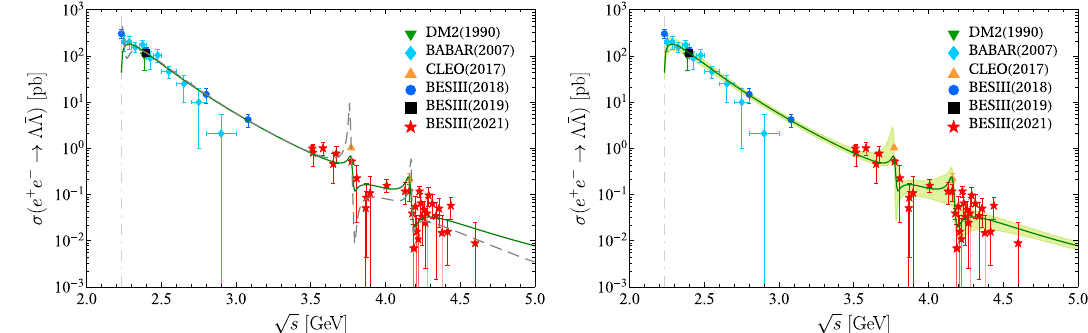
Fig. 1 Resultsofthefittothefulldatasetsforthetotalcrosssectionsof the reaction e + e − → ¯ (cid:2)(cid:2) that taken from Refs. [15,16,18,20,21,25]. Left panel: comparison between Fit-I (dashed line) and Fit-II (solid